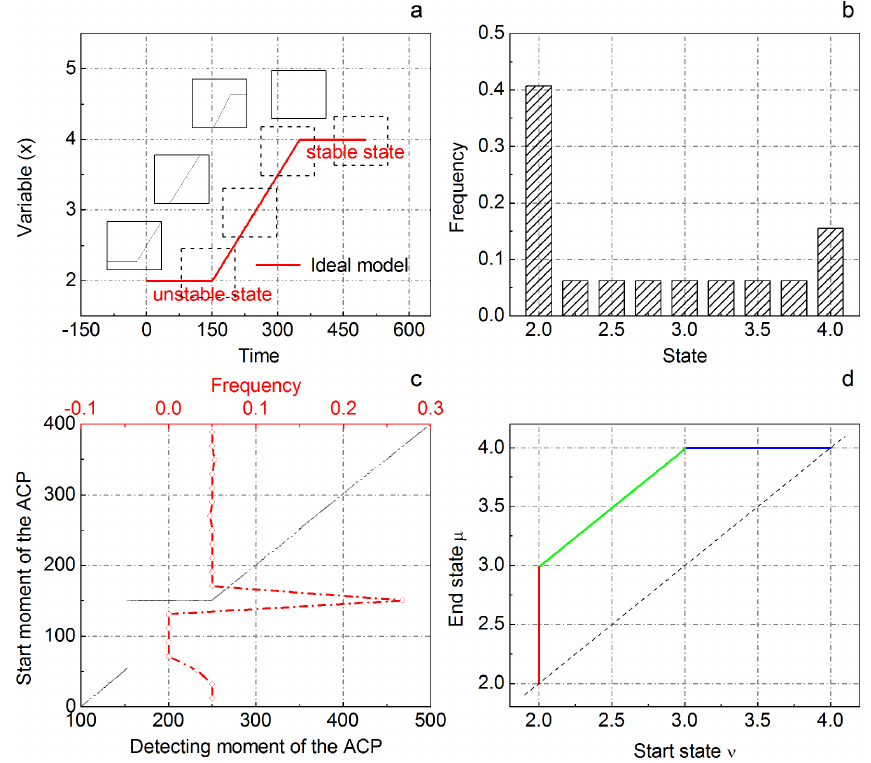
Figure 5. The detection of the abrupt change process of the ideal model and the analysis of the results. (a) The ideal model (red line) and its detection of the abrupt change process in different observed windows (black lines) with sub-sequences; (b) the statistics of the start states; (c) the relationship between the detecting moment and the start moment (blue line), and the frequency of the star moment (red line); (d) the phase diagram of “start–end”